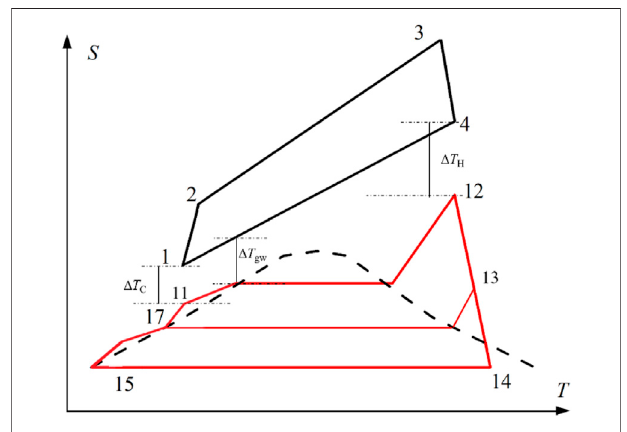
FIGURE 2 | Temperature-entropy diagram of the CC-HTGR.